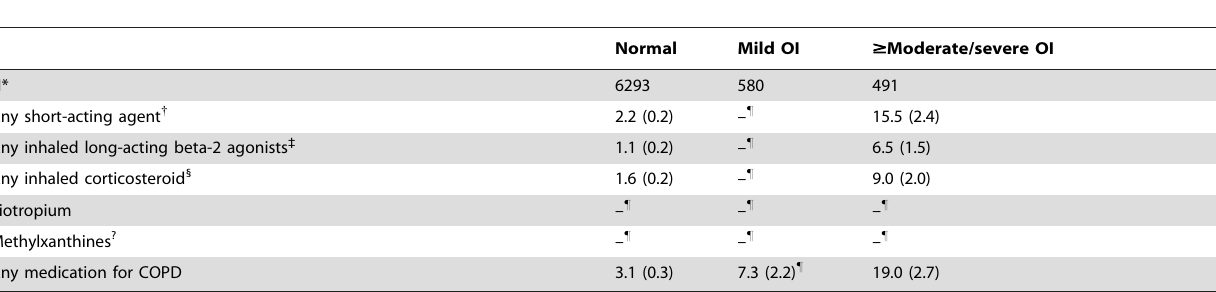
Table 5. Age-adjusted percentages (standard error) of adults aged 20–79 years taking prescription medications for chronic obstructive pulmonary disease defined by spirometry, by Global Initiative for Chronic Obstructive Lung Disease status, National Health and Nutrition Examination Survey